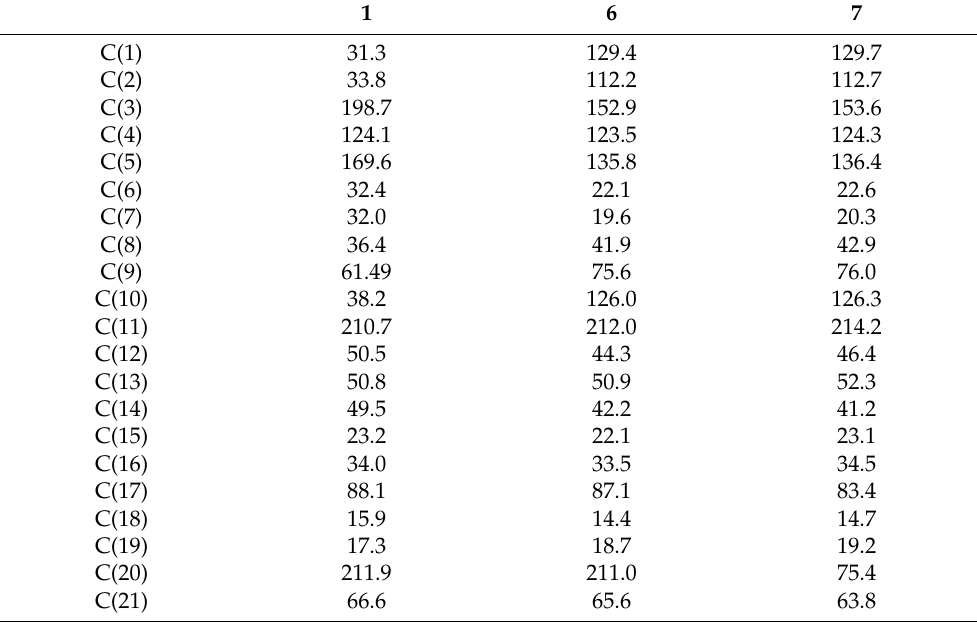
Table 5. 13 C-NMR data of compounds 1 , 6 , and 7 at 100 MHz in DMSO- d 6, δ in